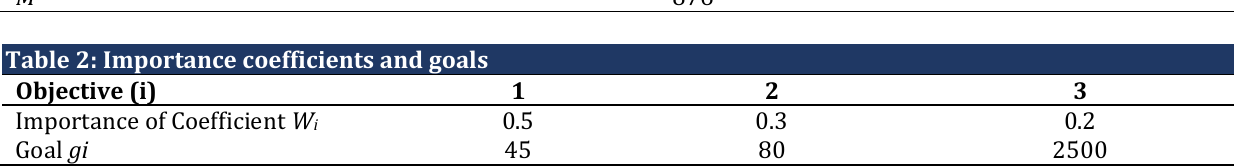
Table 1: Capacity of each block Block (i)